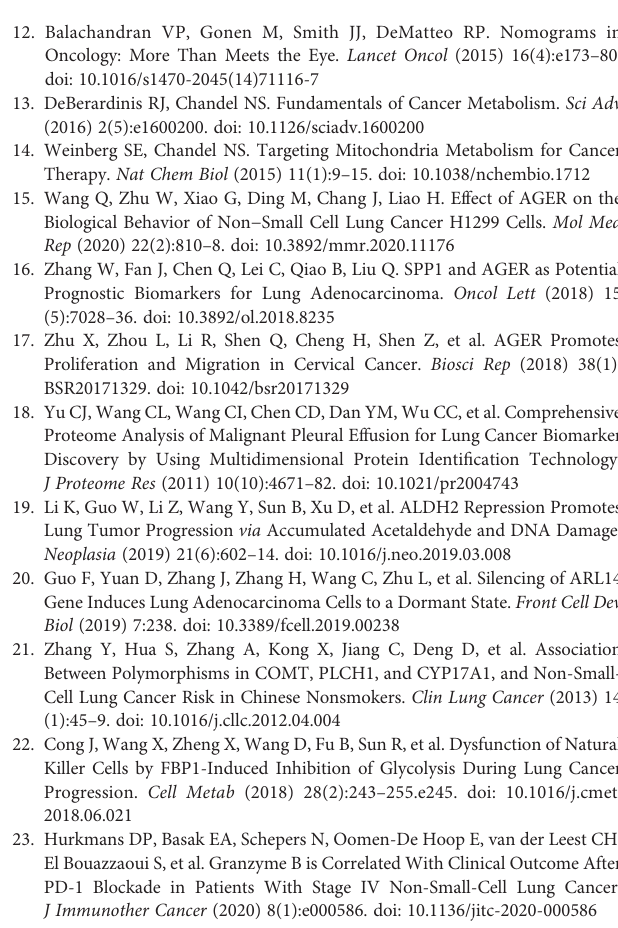
Supplementary Figure 1 | Flowchart presenting the process of establishing the gene signature and prognostic nomogram of LUAD in this study. Supplementary Figure2 | Theexpression of 13 genesin six HumanProtein atlas and Kaplan – Meier curves of the OS of CYP17A1. Supplementary Figure 3 | Kaplan – Meier curves of the OS of 12 genes in the Kaplan-Meier plotter database. Supplementary Figure 4 | Calibration curves of 1-, 3-, and 5-year OS in GSE31210 cohort (A – C) and GSE68465 cohort (D – F) . The Y axis represents the actual OS while the X axis represents nomogram predicted